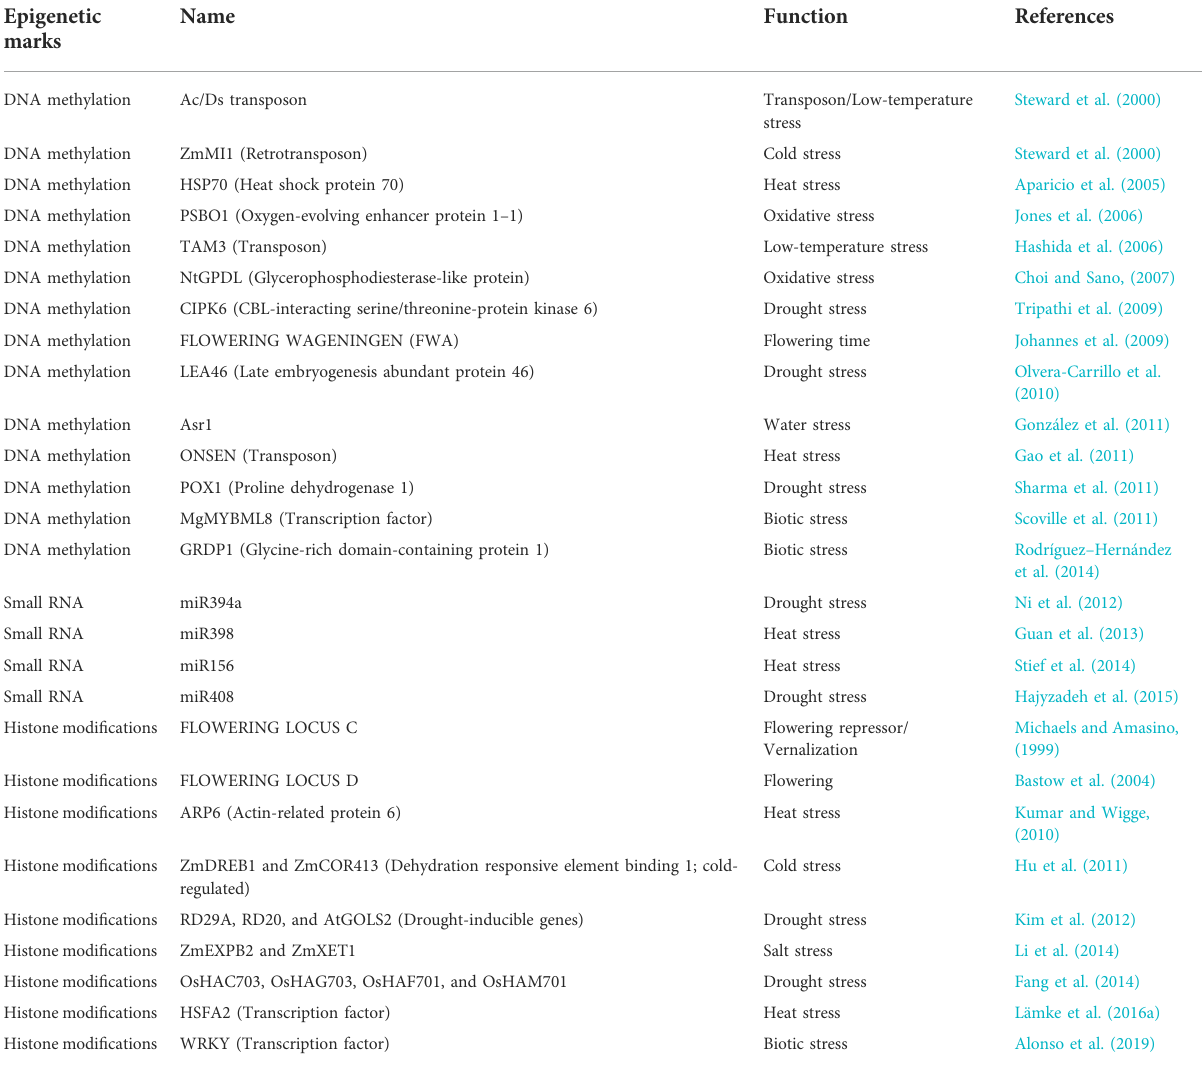
TABLE 5 List of candidate genes regulated by epigenetics in GxE